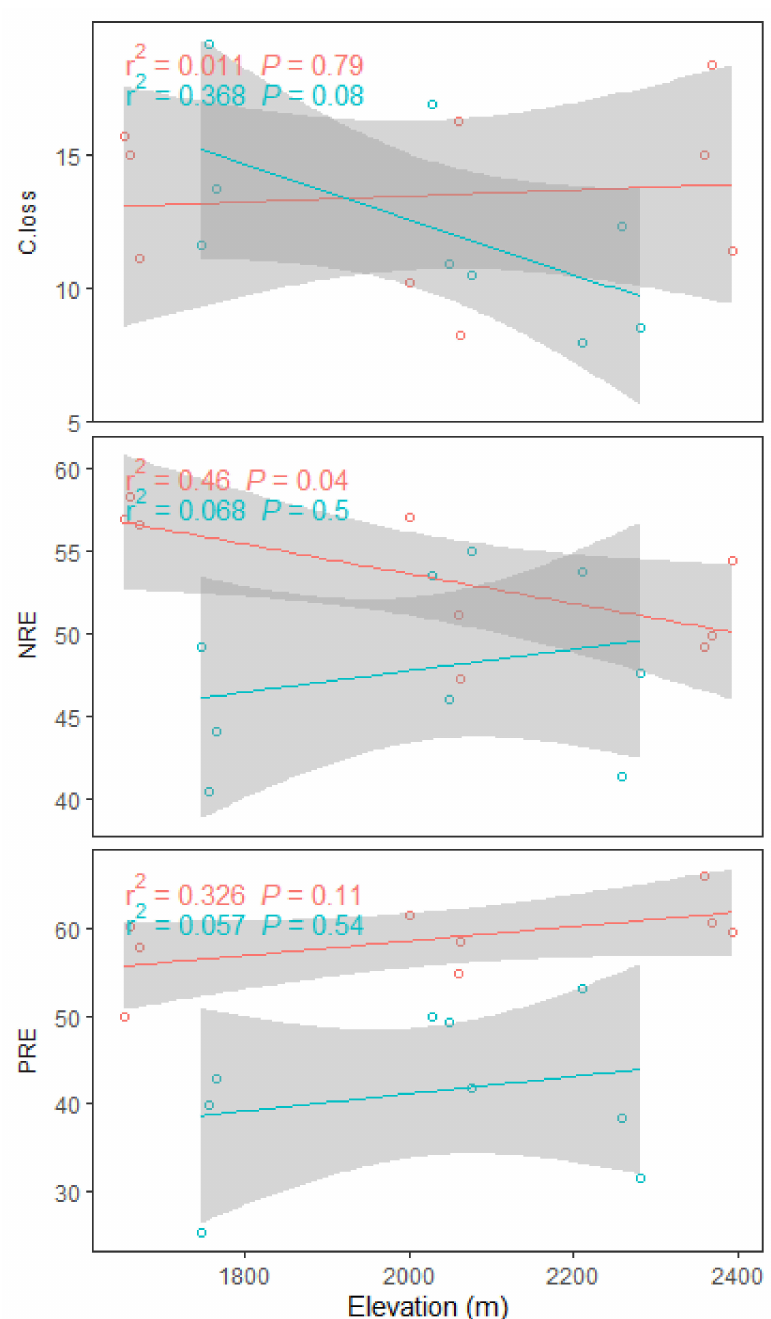
Figure 4. Changes in nutrient resorption e ffi ciency (NuRE) with elevation for two origins of Larix principis-rupprechtii forests (red and blue are planted and natural, respectively). Lines and shade represent fitted regressions and corresponding 95% confidence